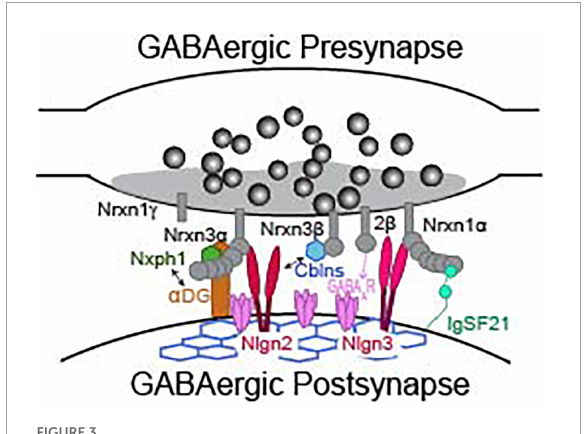
FIGURE3 Presynaptic neurexins and their binding partners at a GABAergic synapse. Not representative of any particular type of inhibitory synapse. See Table 2 for details about binding